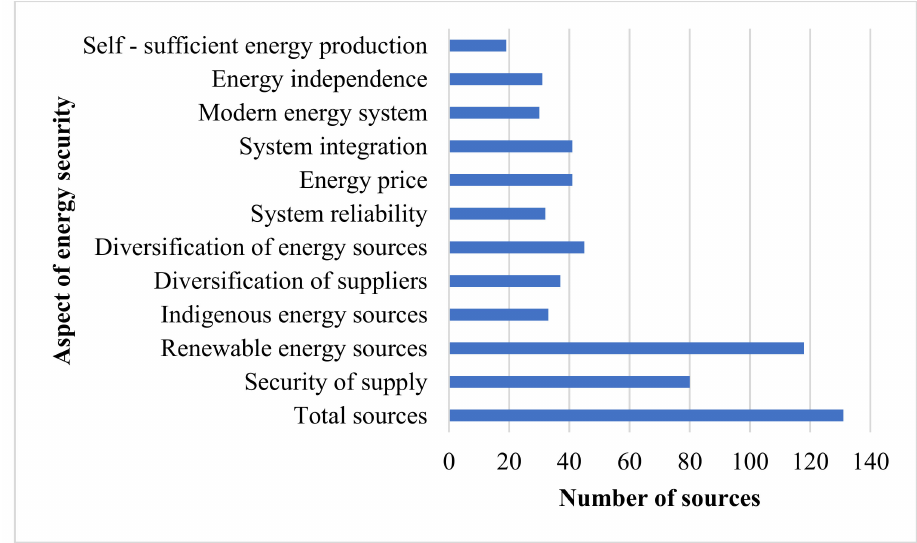
Figure 7. Classification of sources by energy security topic examined (created by the